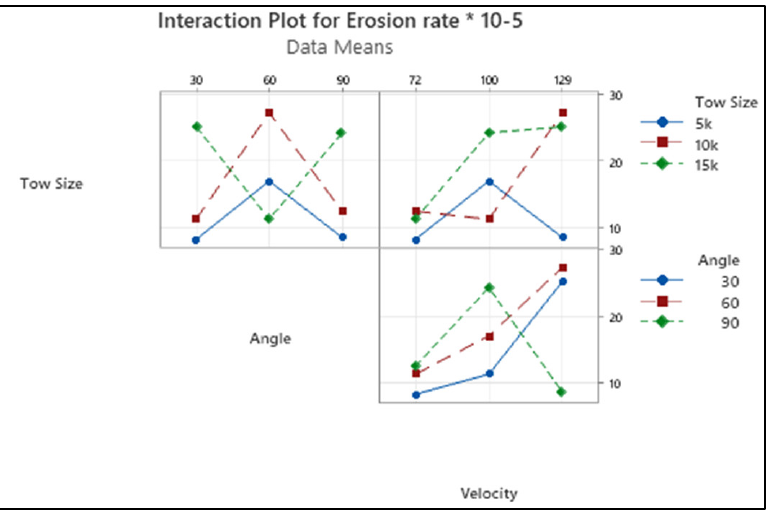
Figure 3. Interaction plot for erosion rate.